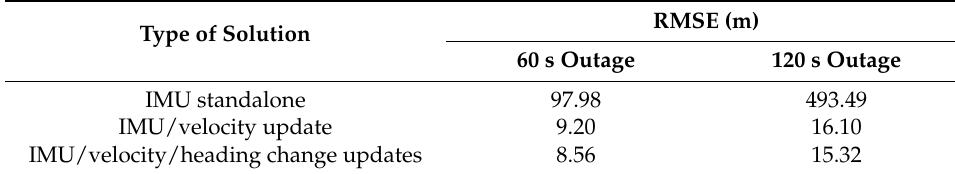
Table 4. Average RMSE for different GNSS signal outage regions of the integrated 2D position states for different types of